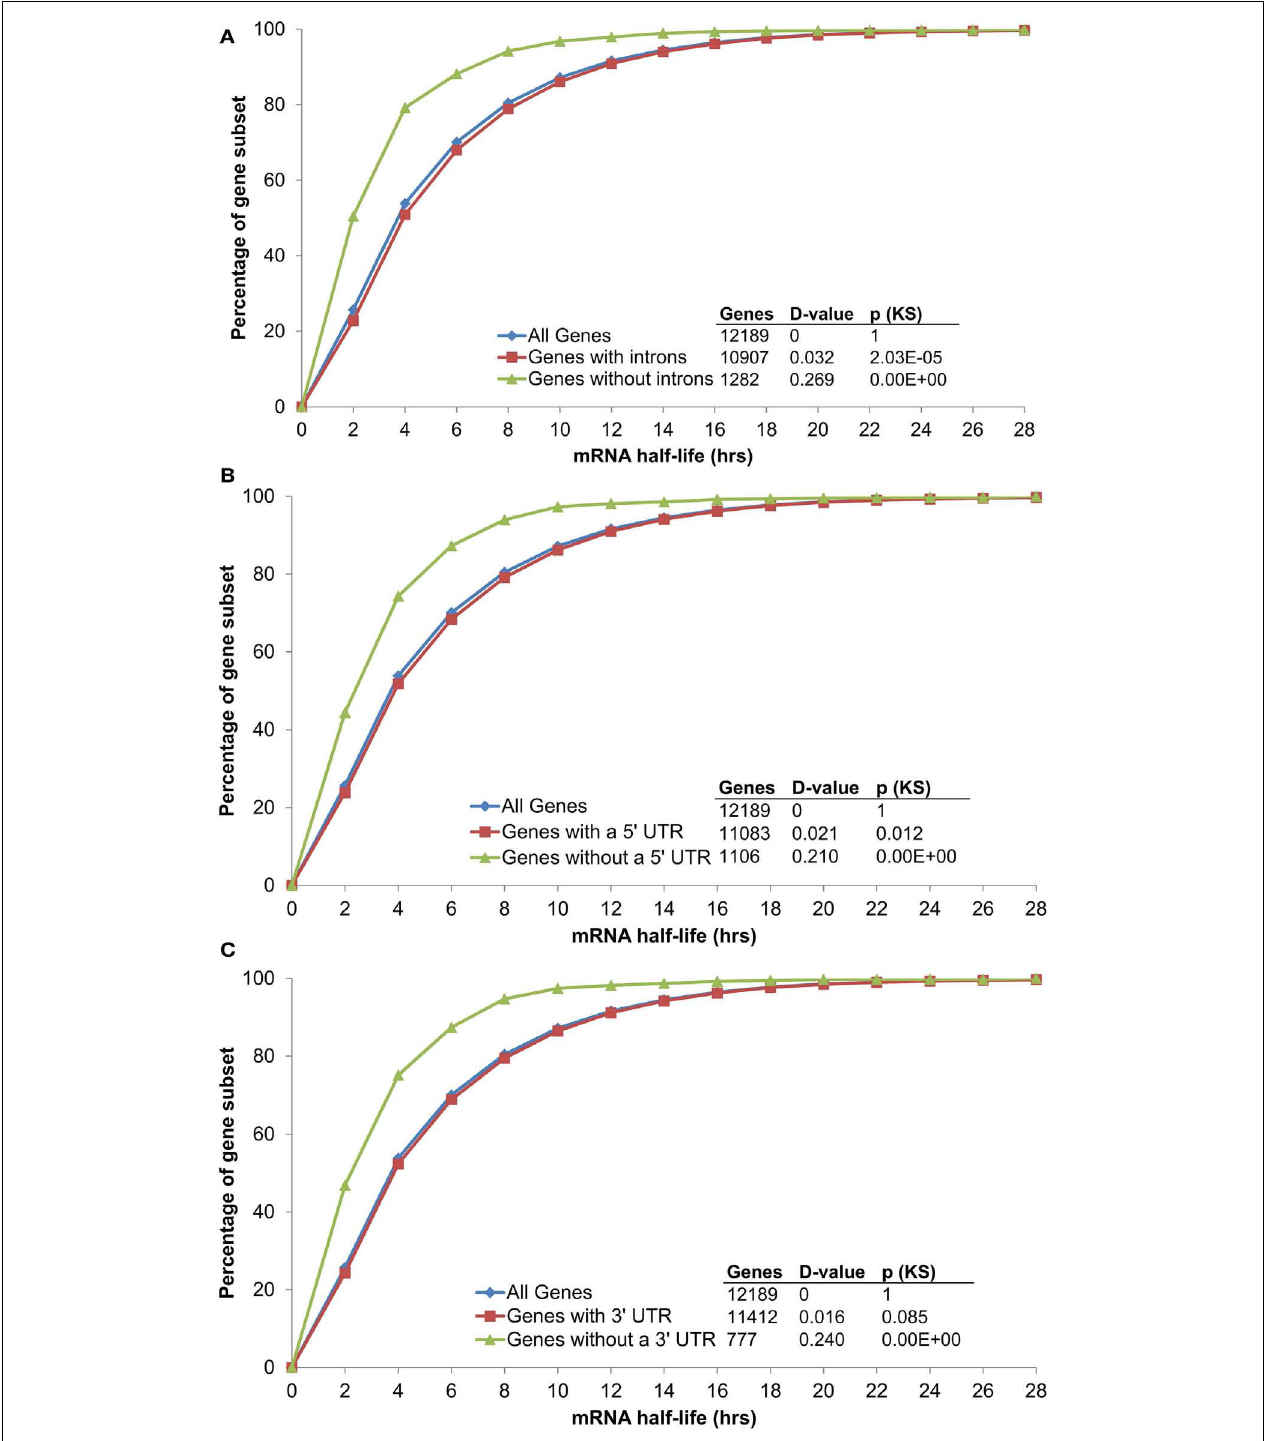
FIGURE 2 |The distribution of mRNA half-lives across genes grouped by (A) intron, (B) 5 (cid:48) UTR, and (C) 3 (cid:48) UTR annotation .